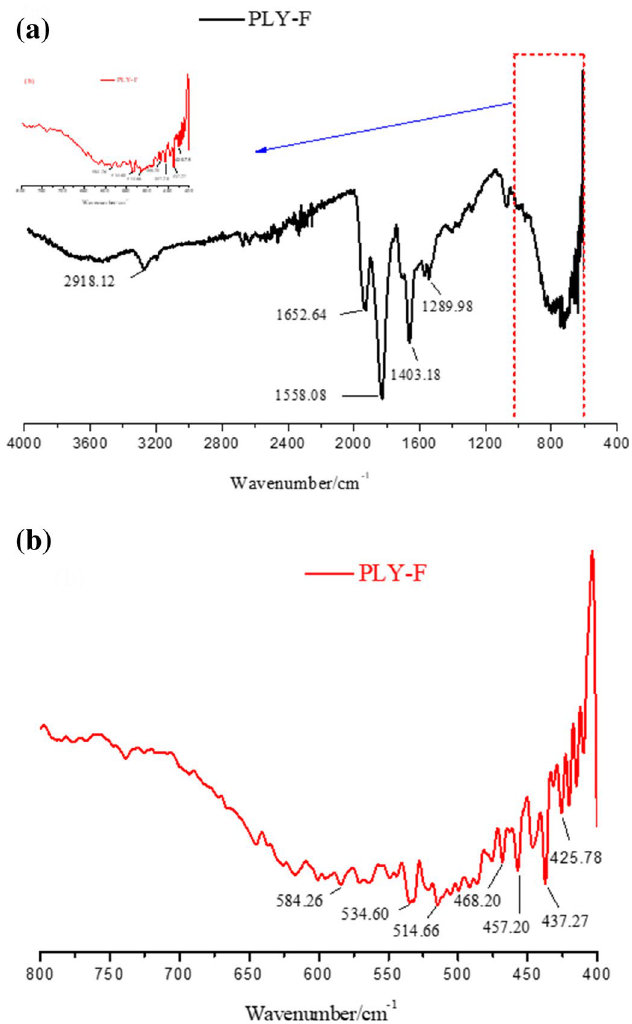
Figure 4. The infrared spectrum of temperature and salt-resistant polymers